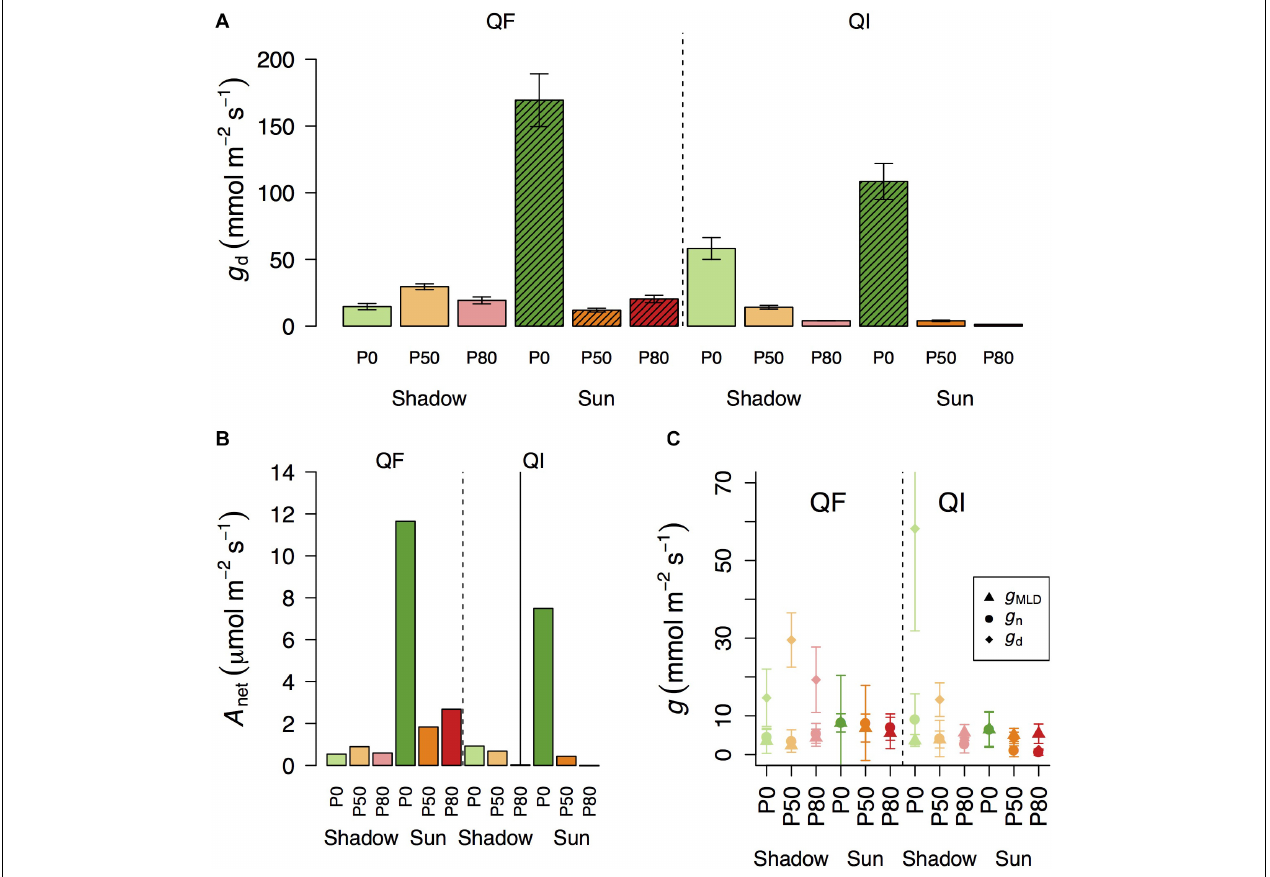
FIGURE 3 | Variation in daytime leaf conductance ( A , g d ) and net assimilation ( B , A net ) across different light treatments (shadow vs sun) and water treatments (P 0 , P 50 , and P 80 ). Bars indicate mean values per treatment and error bars indicate SE. Hatched bars in (A) indicate that A net in that treatment is significantly higher than 1. (C) Differences in residual conductance as measured by from the mass loss of detached leaves (g MLD ), from nocturnal conductance under high D ( g n ), or from g d when A net was smaller than 1 [note that some values of g d are missing in (C) if A net for that treatment was higher than 1]. Error bars indicate 95%